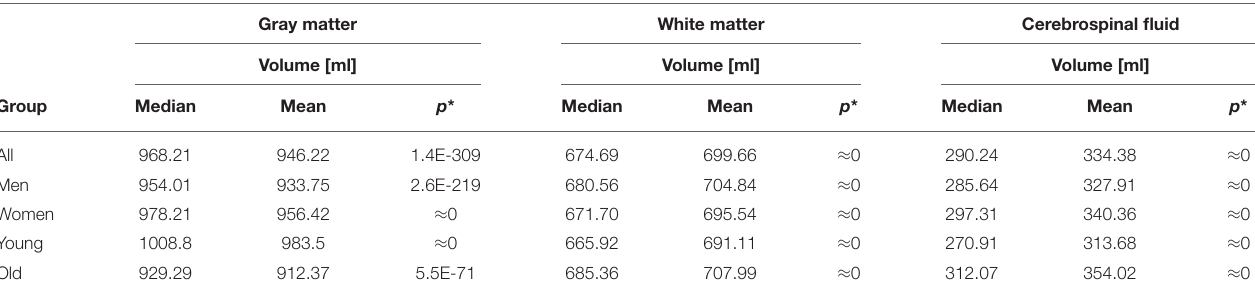
The TPM volumes of GM, WM and CSF obtained for the parametric (mean) and non-parametric (median) methods. The rows present the values for each group (All, Men, Women, Young and